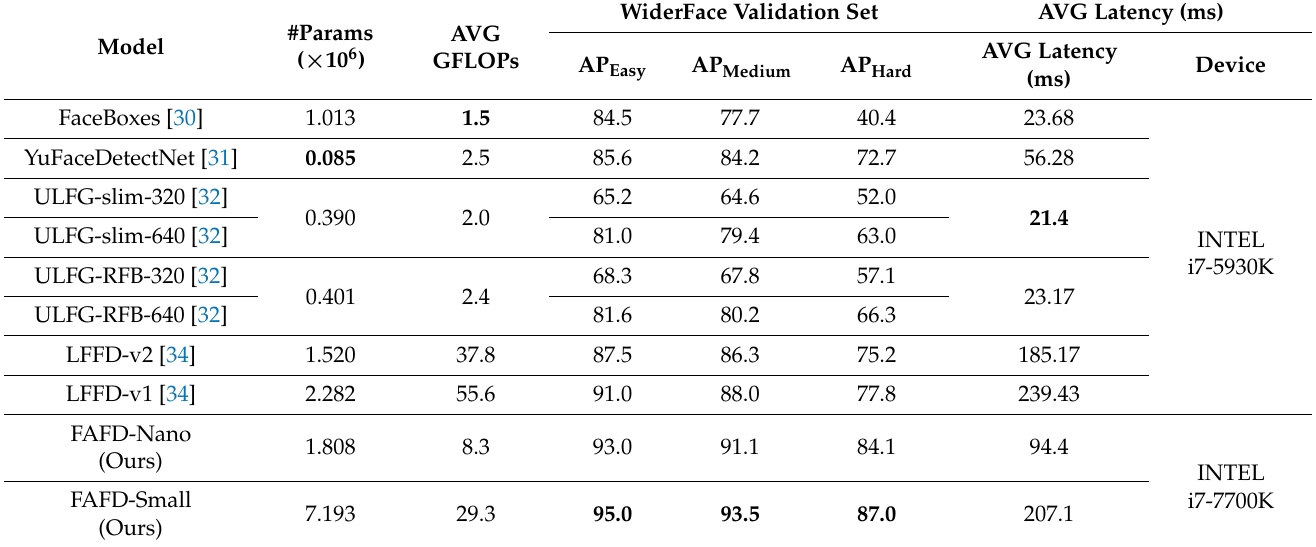
Table 4. Comparison of our FAFD and the Speed-Focusing face detectors on the WiderFace vali- dation dataset. AVG GFLOPs and AVG Latency are the average GFLOPs and the average Latency, respectively, for 100 images with different